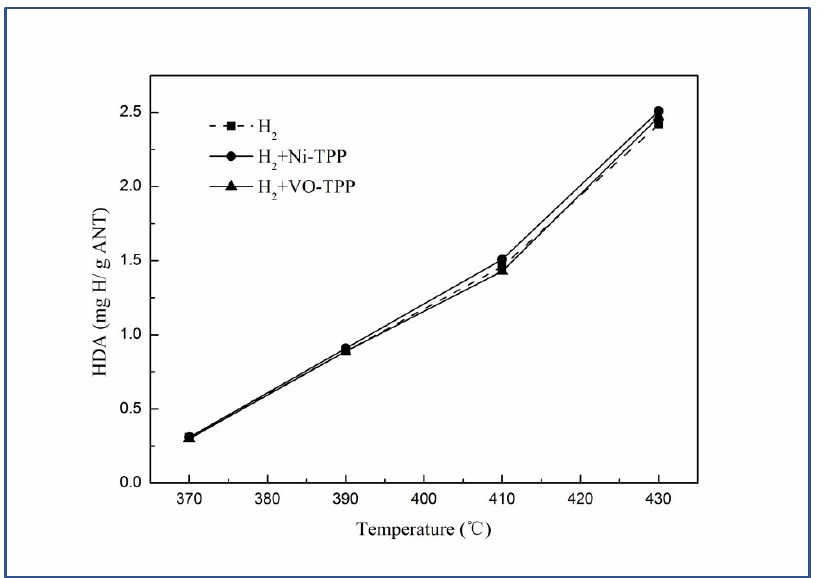
Figure 4. HDA of hydrogen with Ni ‐ TPP and VO ‐ TPP.